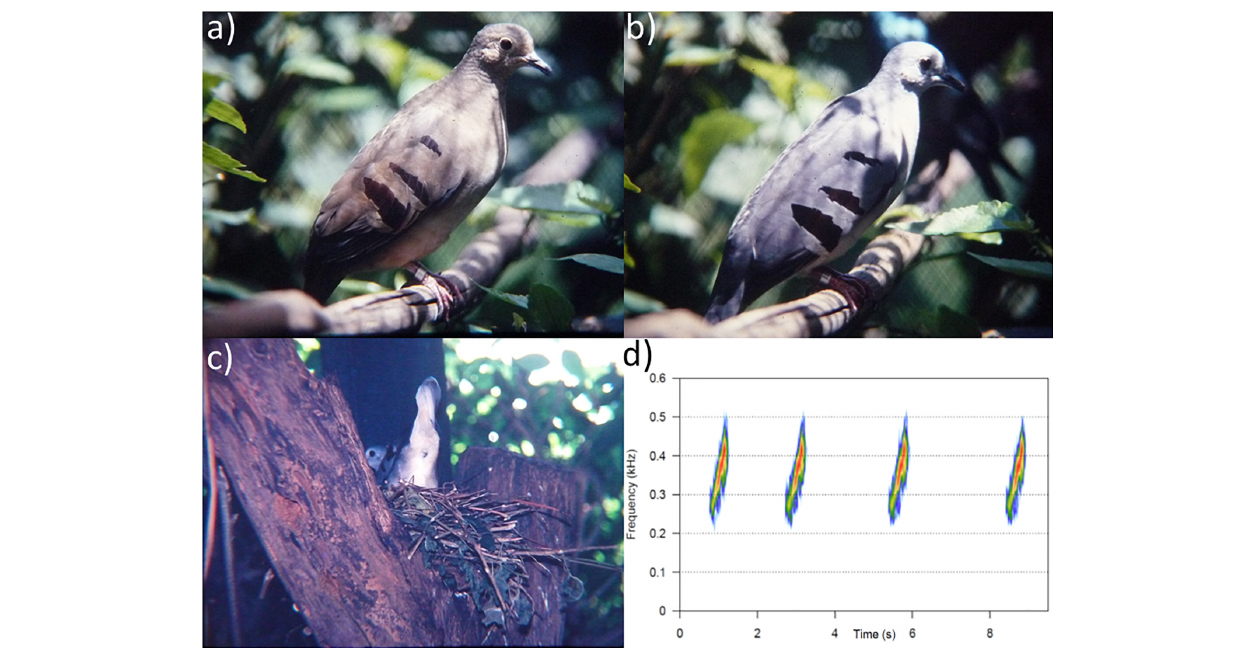
FIGURE 5 | Portraits of captive Purple-winged Ground Doves (a) female, (b) male, and (c) incubating male on a nest at Criadouro Tropicus, Pirassununga, São Paulo in 1988, in addition to the last documented wild individual with (d) sonograms of the vocalizations of a captive Purple-winged Ground Dove obtained in 1992 ML#273900 (images (a – c) and recording by Carlos